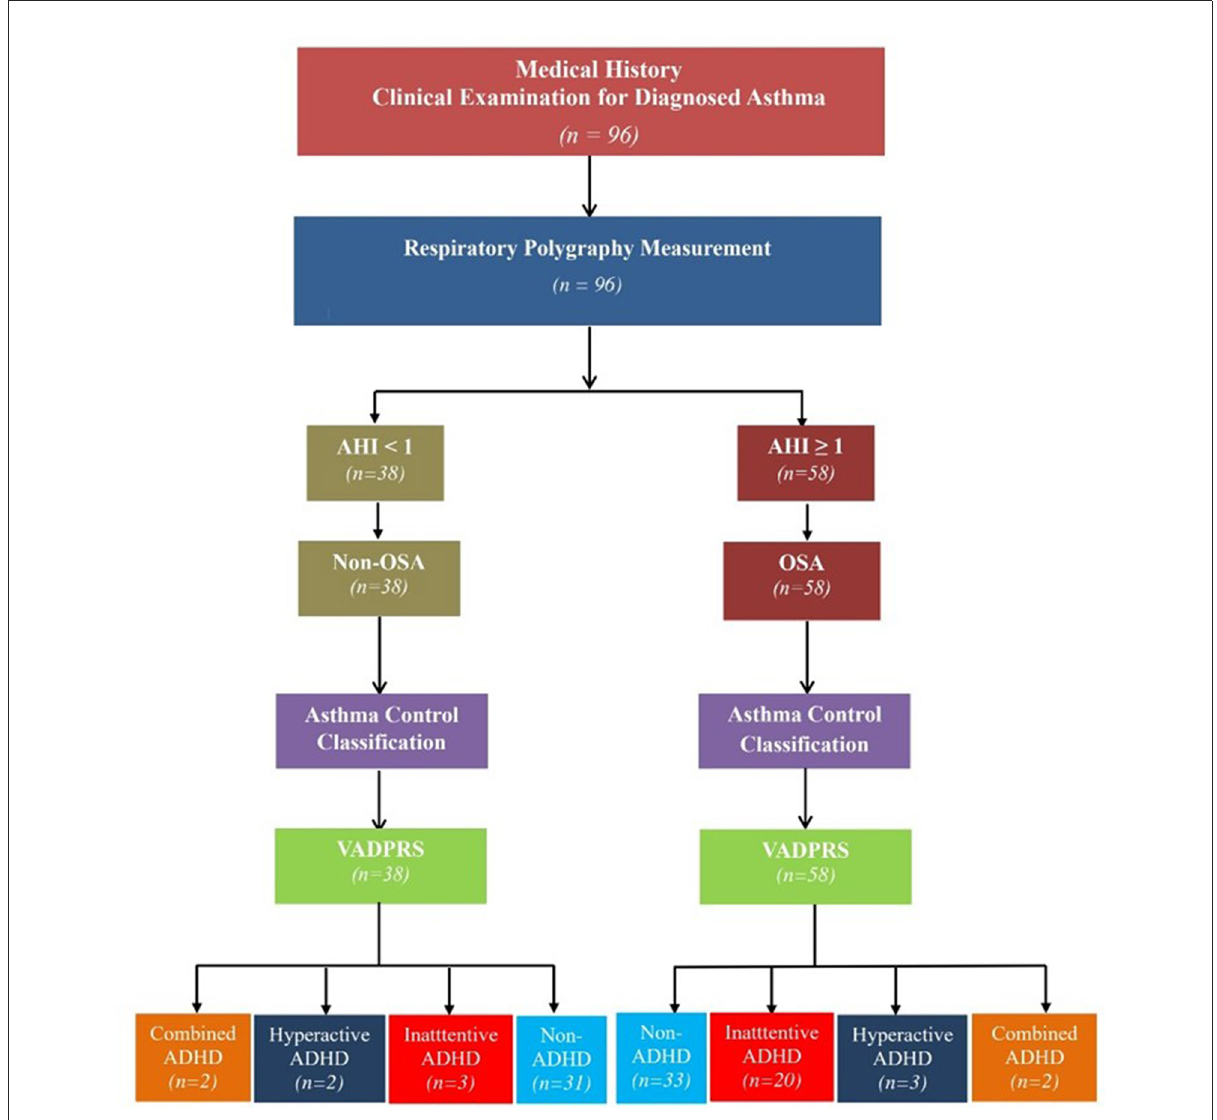
FIGURE1 Flowchart of the study procedure. ADHD, attention deficit and hyperactivity disorder; AHI, apnea-hypopnea index; OSA, obstructive sleep apnea; VADPRS, Vanderbilt’s ADHD Diagnostic Parent Rating Scale.